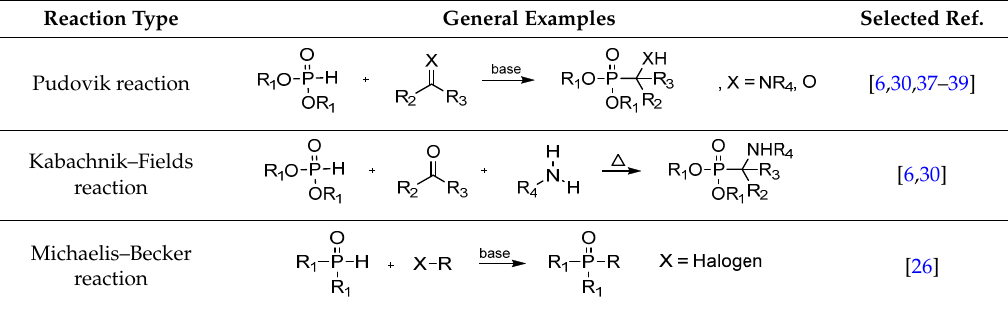
Table 1. P-H transformation into P-C bond.